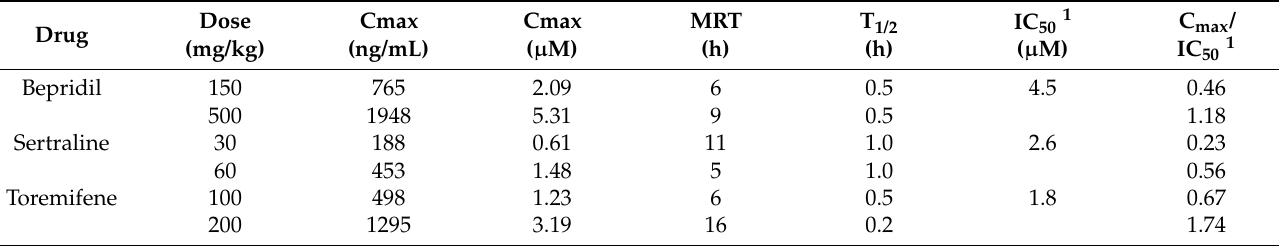
Table 3. Oral PK in mice following drug administration in V8.